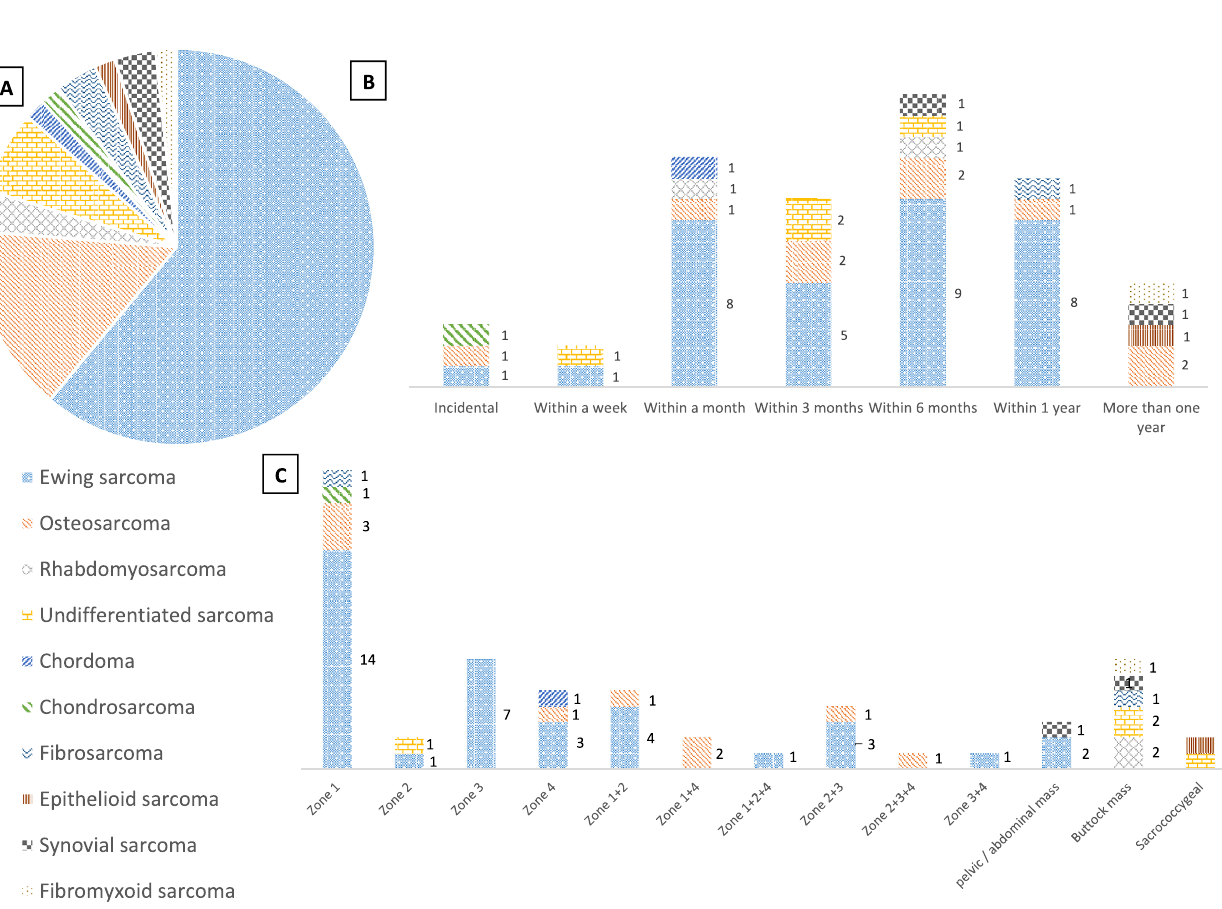
Figure 2. Patients ’ characteristics strati fi ed by tumor type (A), time to presentation and tumor type (B), and anatomic location (Enneking zones) and tumor type